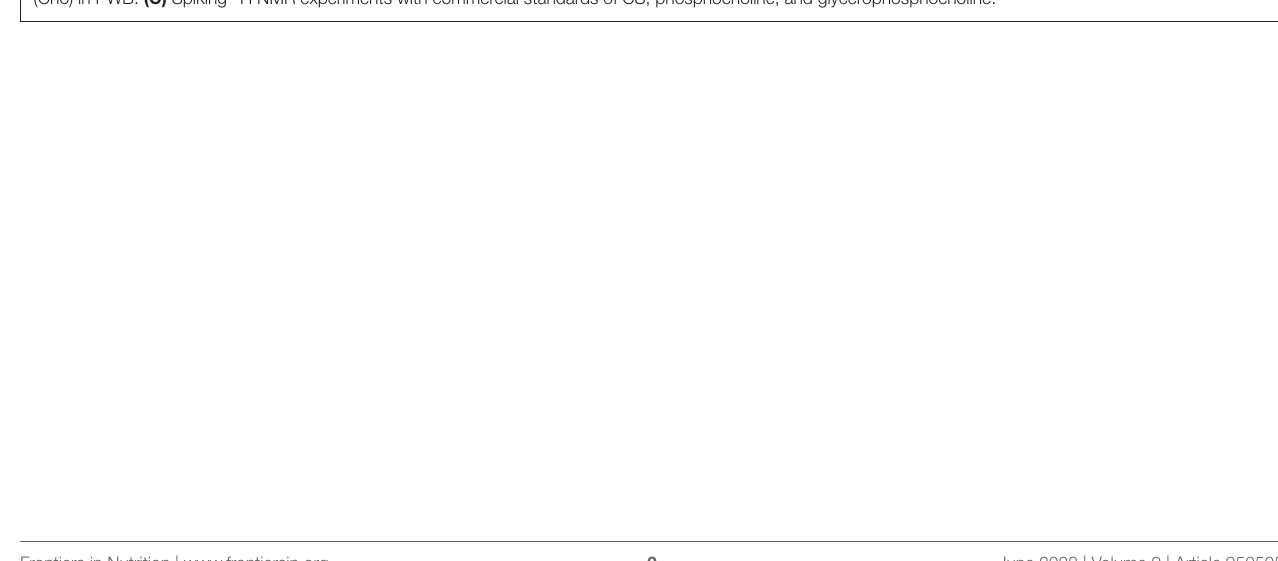
Frontiers in Nutrition |